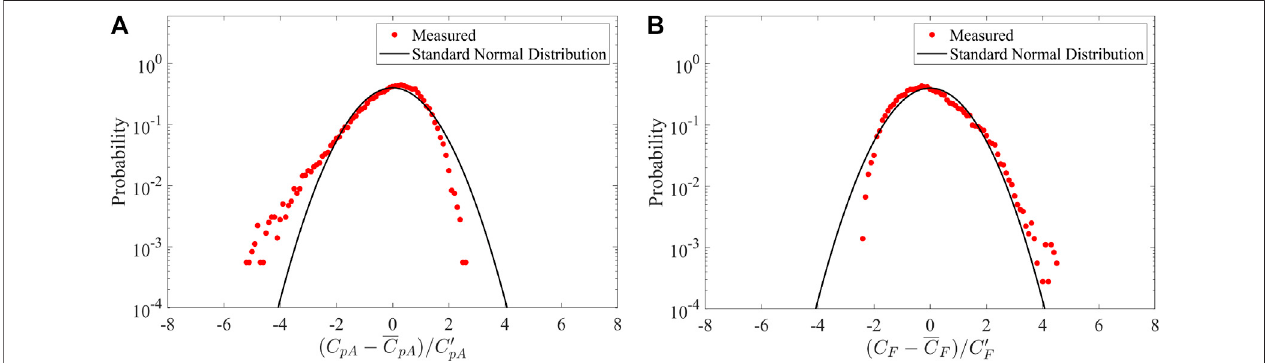
FIGURE 11 | Probability distributions for D/B (cid:1) 1 for (A) area-averaged pressure coef fi cients on the side wall and (B) drag coef fi cients.